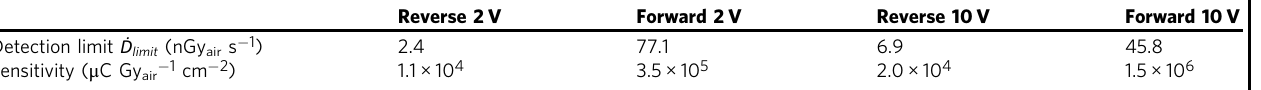
Table 3 # 2 Pb/Au device detection limit Ḋ limit and sensitivity under reverse vs forward bias